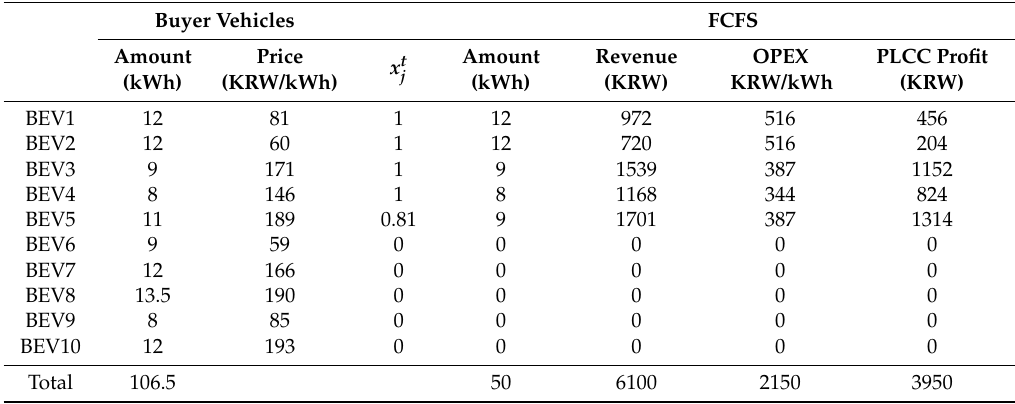
Table 8. Case (2) with FCFS for electric vehicles as buyers and the PLCC as a seller.